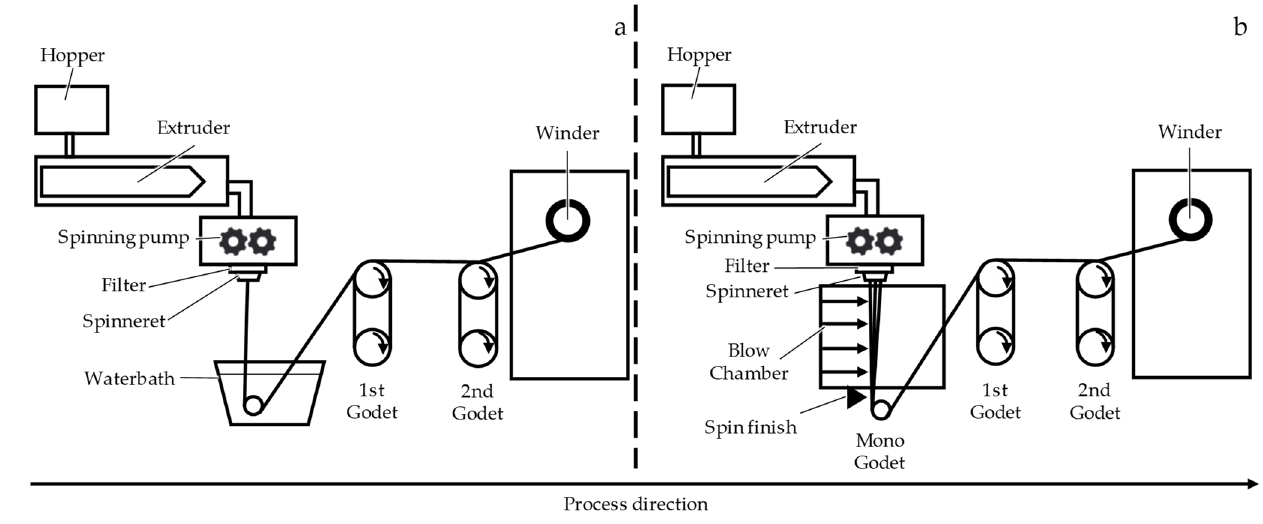
Figure 1. Process schematics of ( a ) monofilament and ( b ) multifilament spinning.